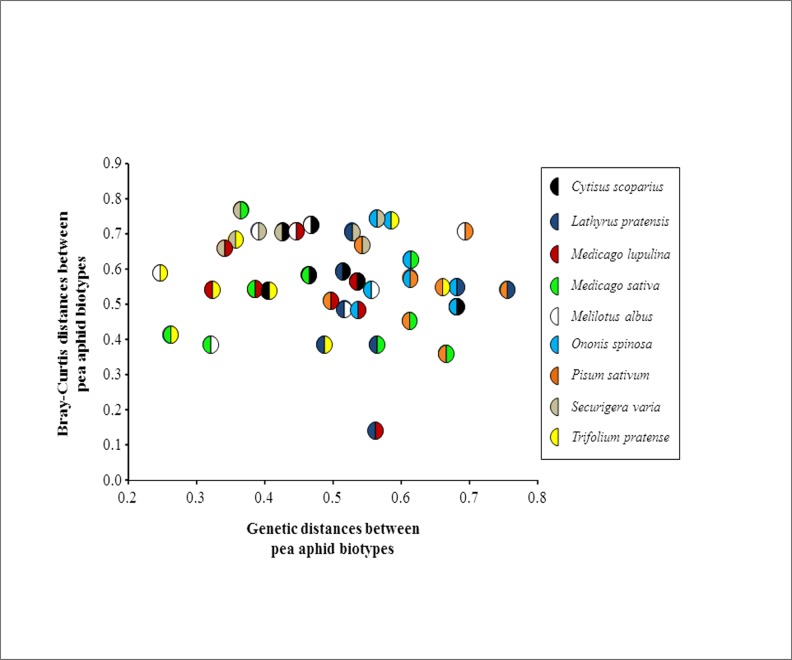
Relationship between the matrix of Bray-Curtis dissimilarities between all pairwise combinations of pea aphid biotypes and the matrix of the genetic distance among these host-adapted aphid populations.Each data point represents a pairwise combination of pea aphid biotype (Mantel test, p>0.05).